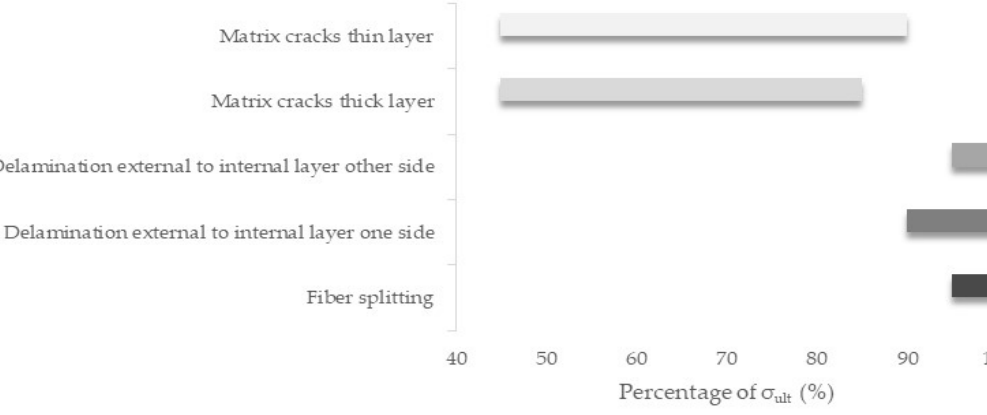
Figure 7. Damage process during the quasi-static tests for the [0°/60°] 2s laminates.